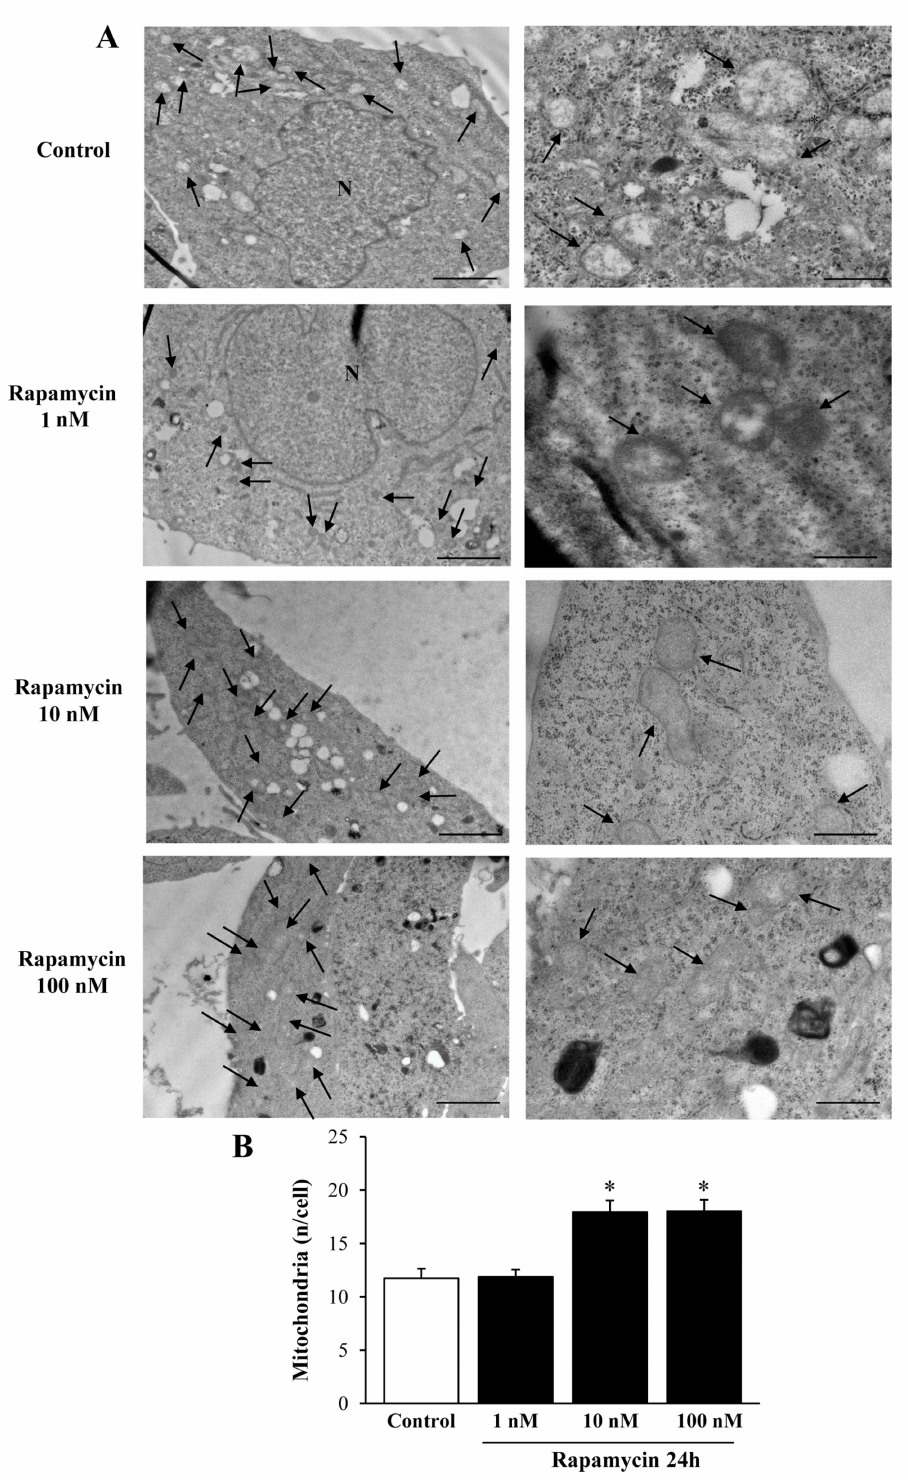
Figure 1. Rapamycin dose-dependently increases mitochondrial number in U87MG cell line. ( A ) Representative TEM micrographs showing mitochondria (indicated by black arrows) from Control and from di ff erent doses of rapamycin. ( B ) Graph reports the number of mitochondria per cell. Values are the mean ± S.E.M. from 50 cells per group. ∗ p ≤ 0.05 vs. Control and 1 nM rapamycin; Scale bars = 1 µ m (low magnification) and 0.56 µ m (high